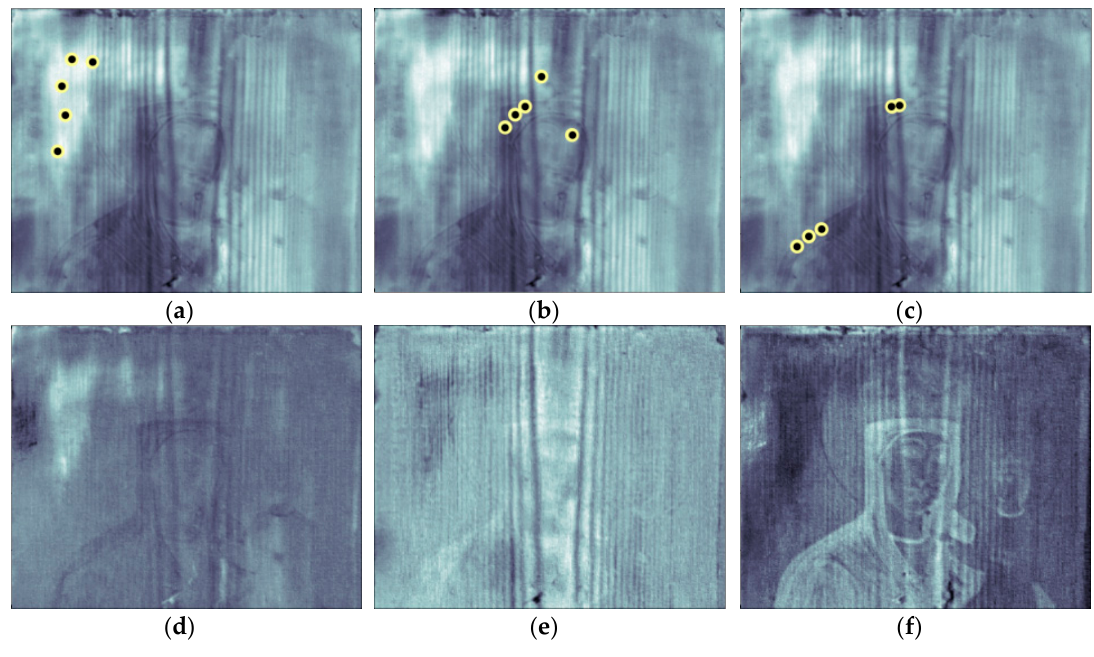
Figure 10. Examples of reconstructed structural images (archetypes): ( a ) points chosen for “defect”; ( b ) points chosen for “structure”; ( c ) points chosen for “drawing”; ( d ) reconstructed “defect”; ( e ) reconstructed “structure”; ( f ) reconstructed “drawing”.